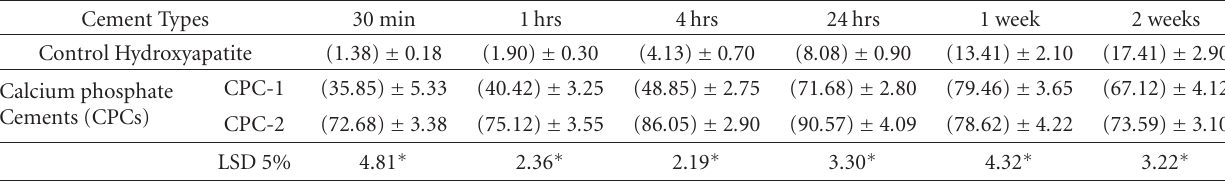
Table 3: Mean compressive strength and standard deviation of hydroxyapatite cement and the two polymeric calcium phosphate cements (CPCs) [the values in parenthesis are in MPa].